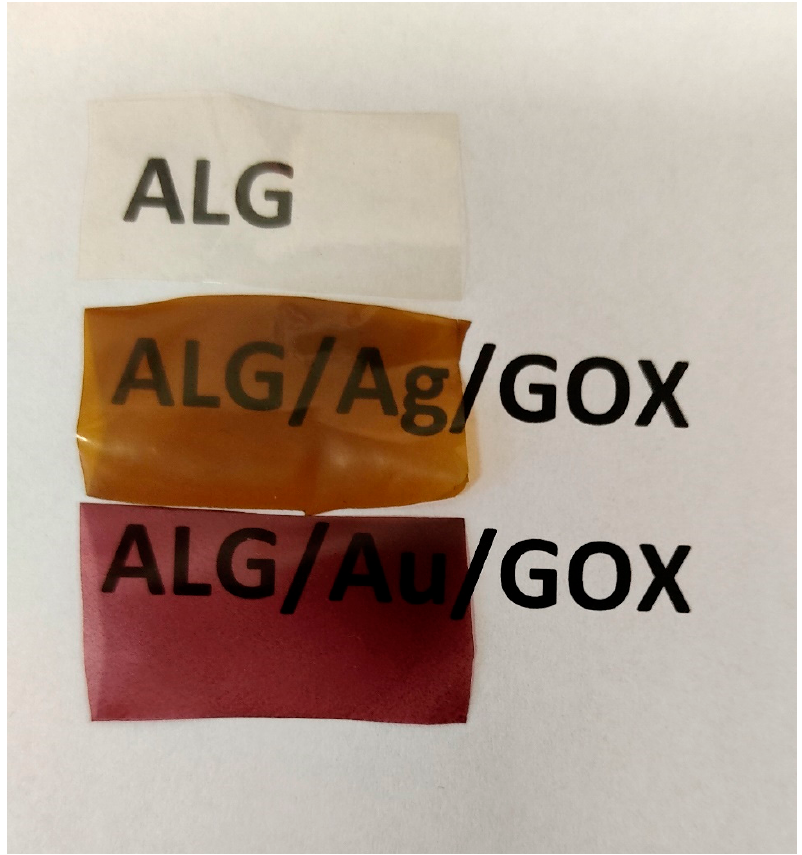
Figure 1. Obtained foils put on their printed